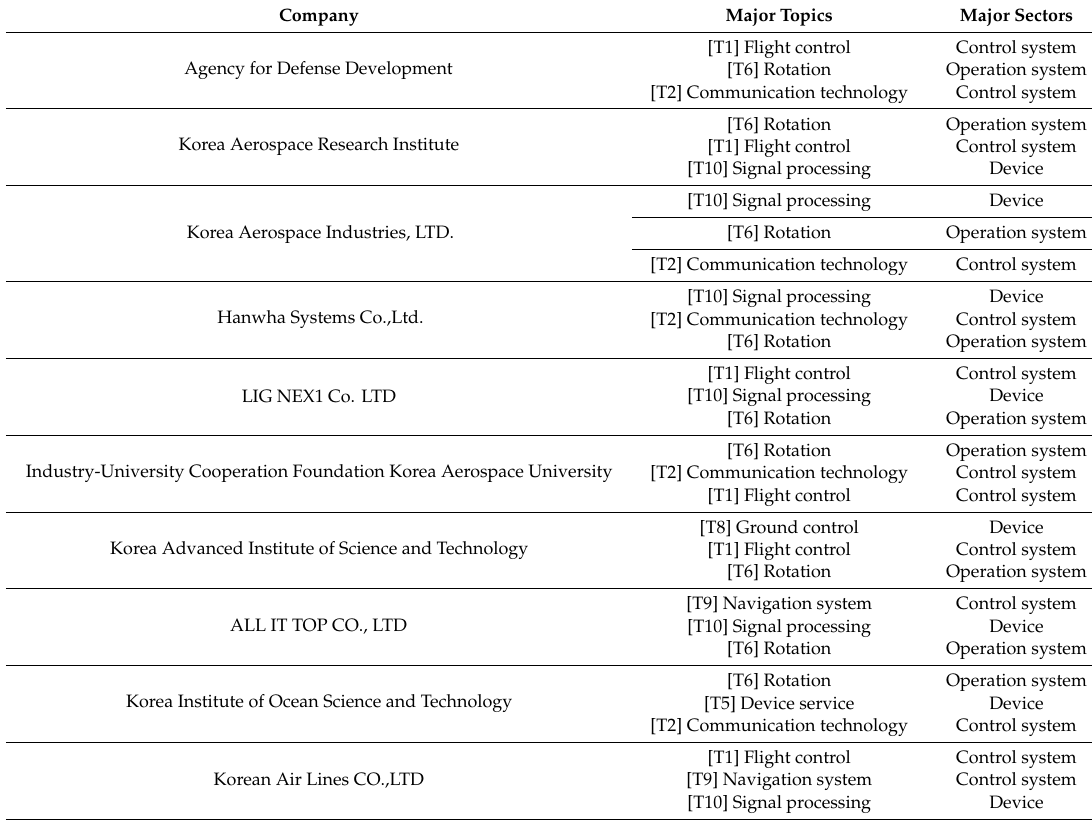
Table 3. Technology strengths of Korean aerospace